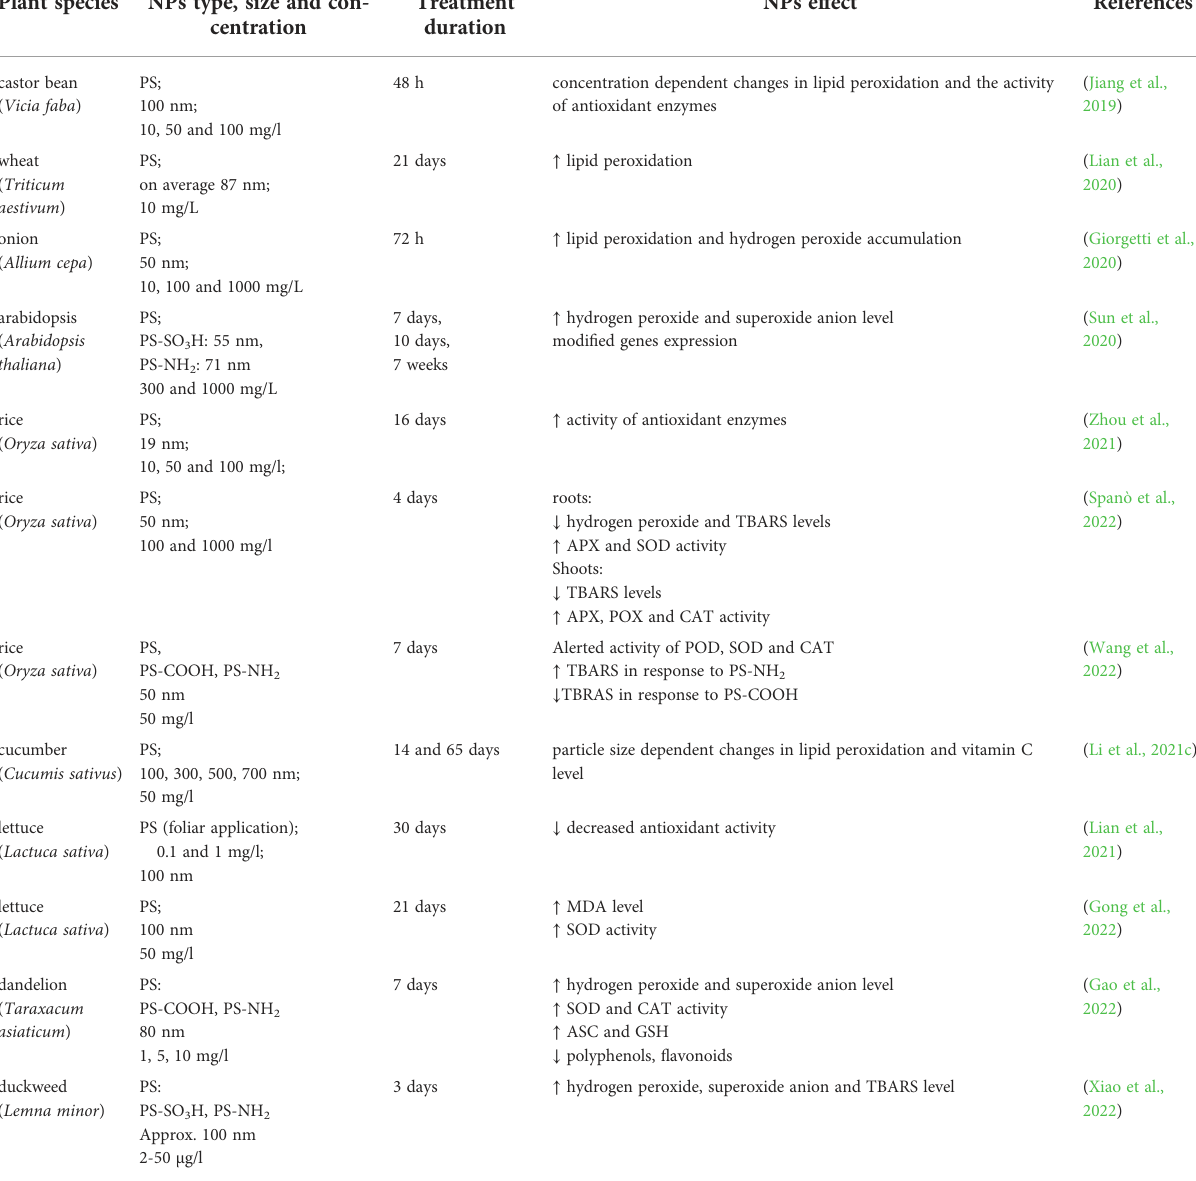
TABLE 1 Summery of plant oxidative response to NP ( ≤ 100 nm); PS, polystyrene; PMMA, polymethyl methyacrylate; MD, malondialdehyde (marker of lipid peroxidation); TBARS, thiobarbituric acid reactive substances (marker of lipid peroxidation); APX, ascorbic peroxidase; CAT, catalase; POX, peroxidases; SOD, superoxide